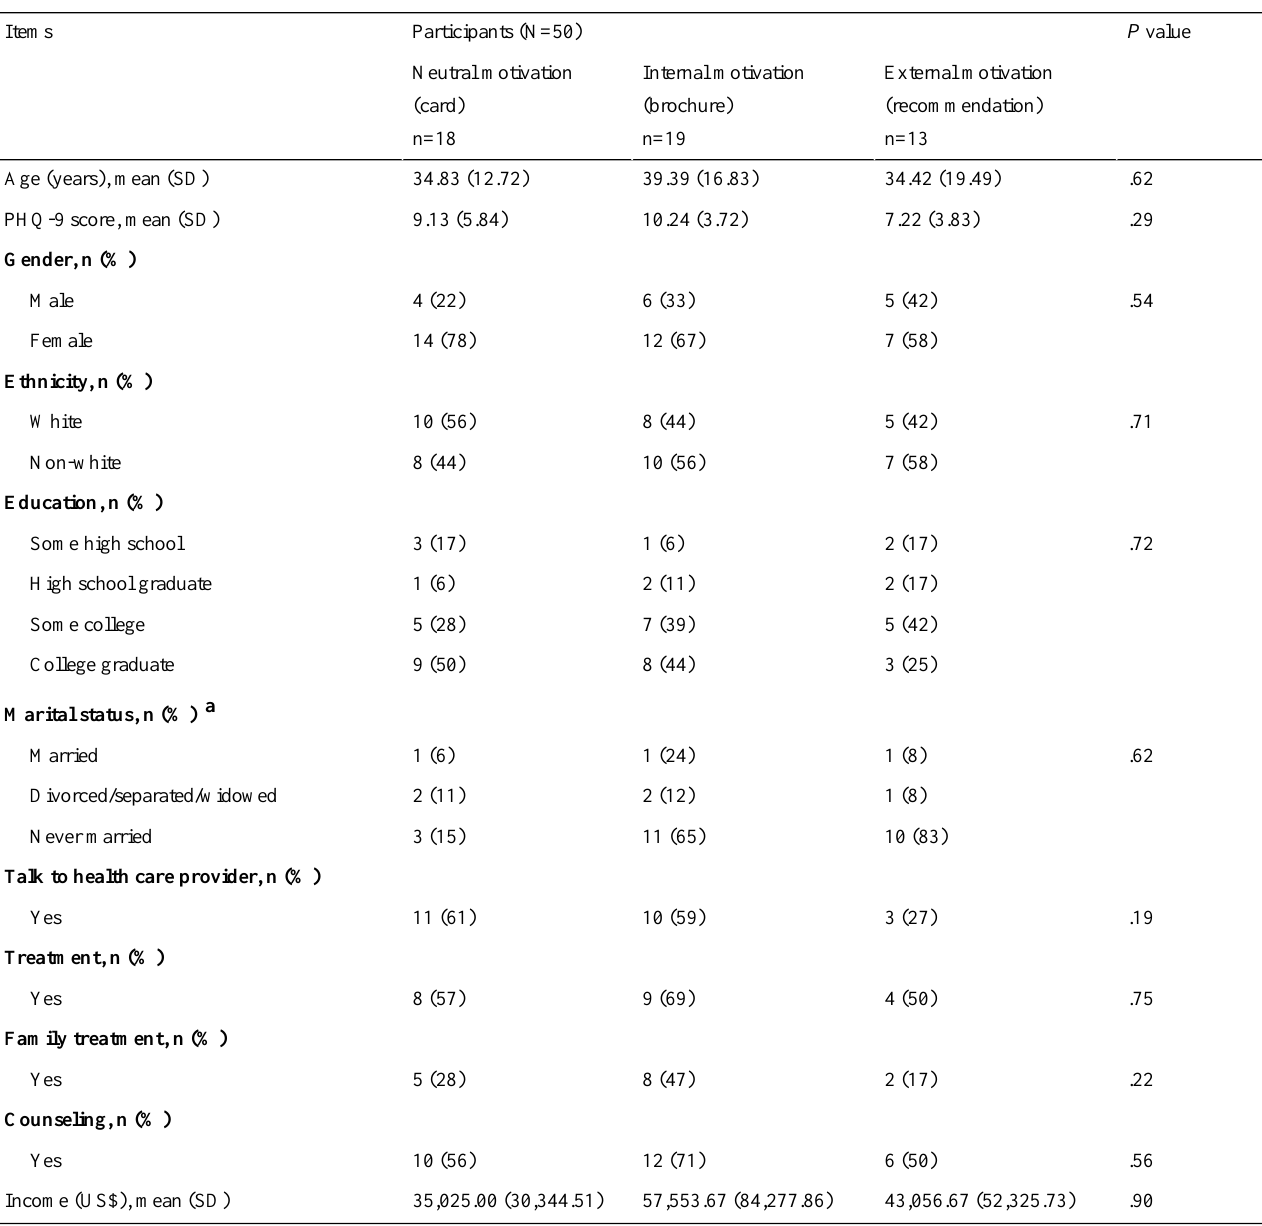
Table 2. Demographics of study